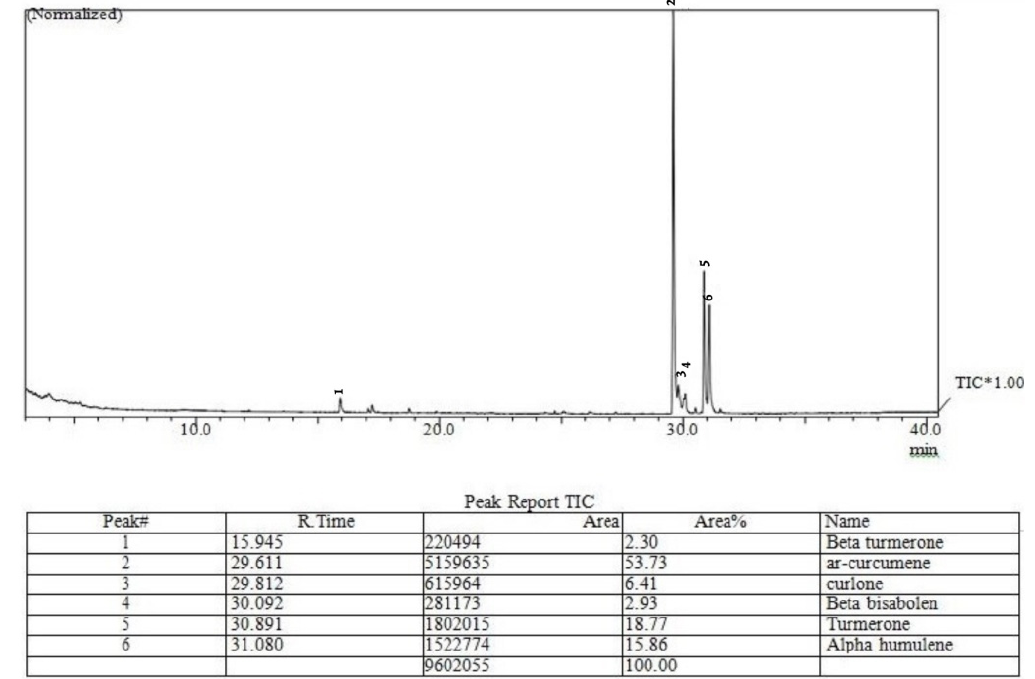
Figure 9. Purity of extracted essential oil tested using gas chromatography-mass spectroscopy.